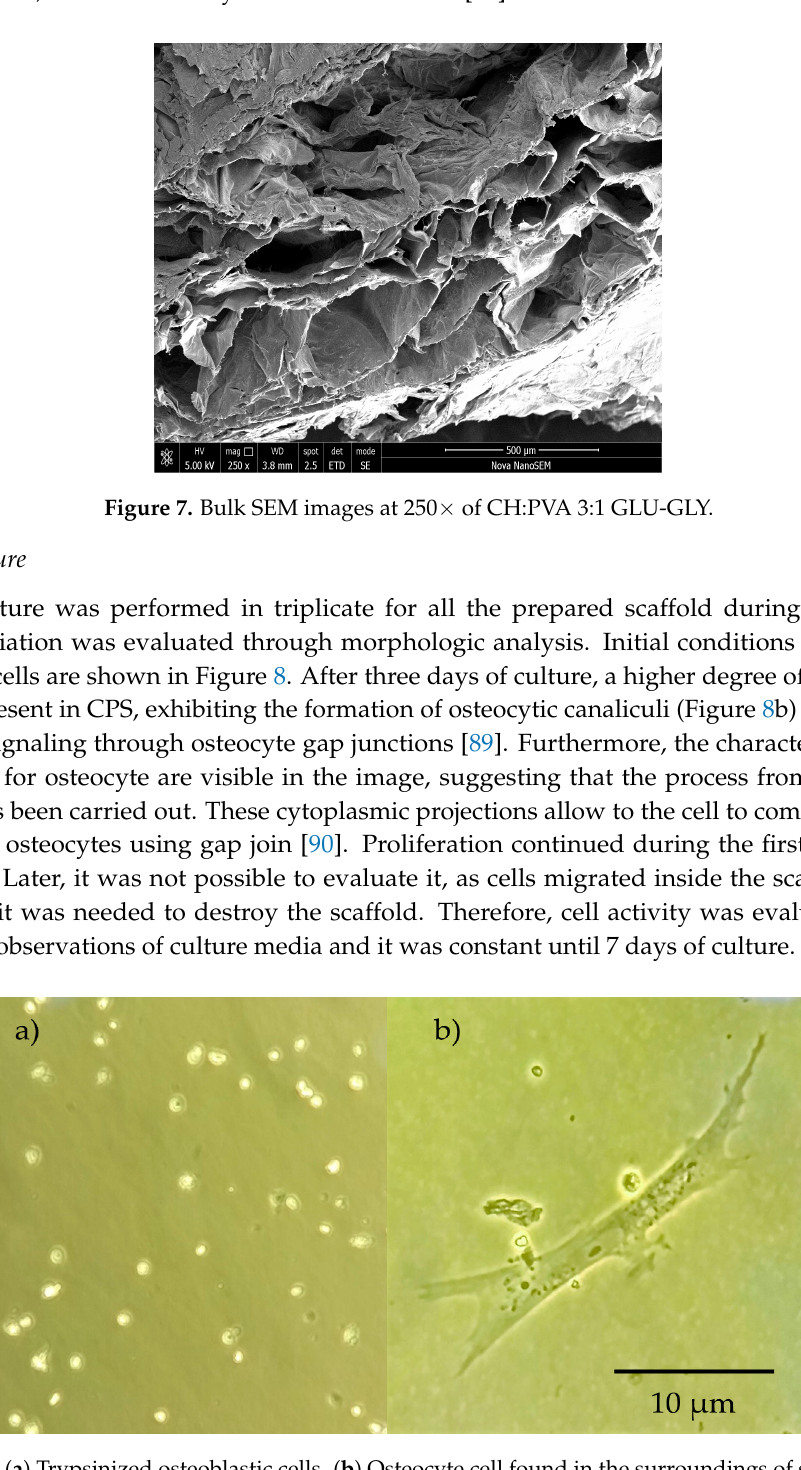
Figure 8. ( a ) Trypsinized osteoblastic cells. ( b ) Osteocyte cell found in the surroundings of sample CH 1:3 PVA + GLU/GLY.